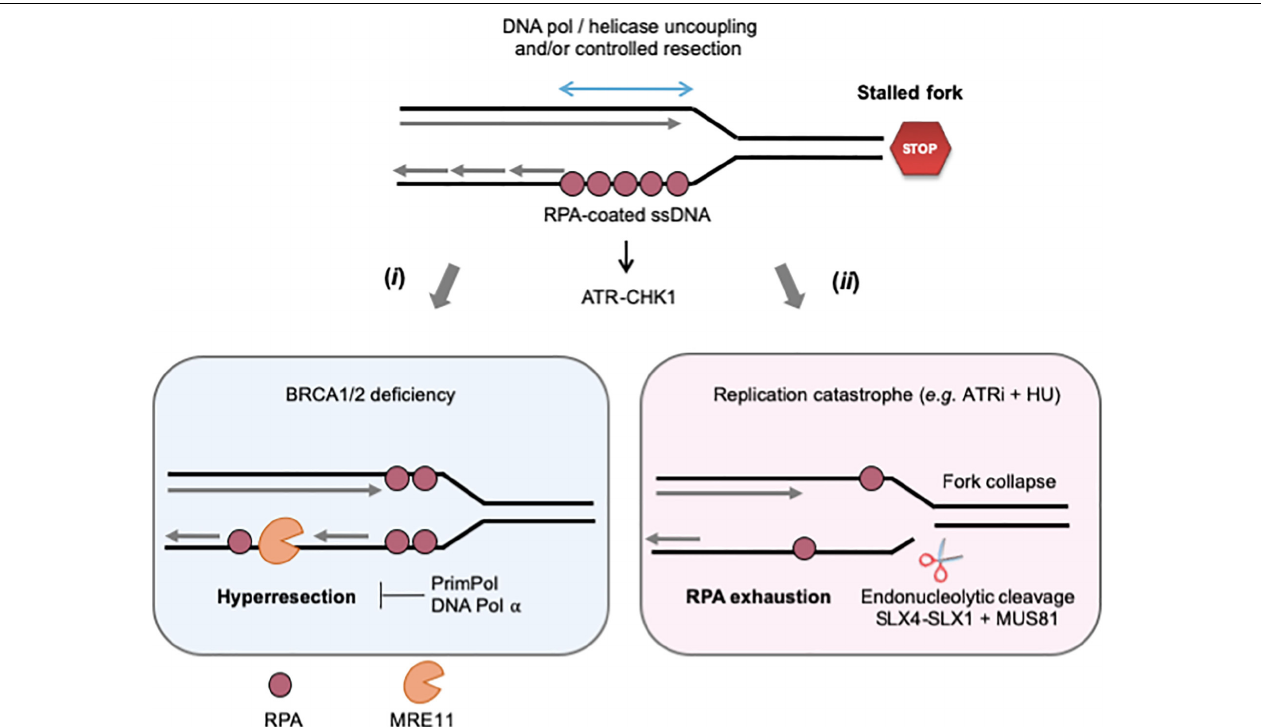
FIGURE 2 | Controlled and pathological formation of ssDNA at stalled forks. When cells are exposed to RS, ssDNA forms at stalled forks through the uncoupling of replicative helicase and polymerase activities and/or the controlled degradation of nascent DNA by MRE11 and other nucleases. The ssDNA exposed is covered by the ssDNA-binding protein RPA, which serves as platform to recruit and activate ATR-CHK1 signaling. ( i ) In BRCA2-deficient cells, large ssDNA gaps form as the result of uncontrolled MRE11-mediated nascent DNA degradation (hyperresection). DNA pol α and PrimPol could either fill these gaps or promote lesion bypass while creating additional gaps in the process. ( ii ) The ATR-CHK1 pathway represses initiation when cells are exposed to acute RS conditions (high doses of APH or HU). In the presence of ATRi, the increased number of stalled forks depletes RPA and cells suffer from replication catastrophe, an event characterized by increased ssDNA exposure and massive fork collapse. Fork breakage may also result from uncontrolled nuclease activities, such as MUS81, SLX4-1. See text for further details.